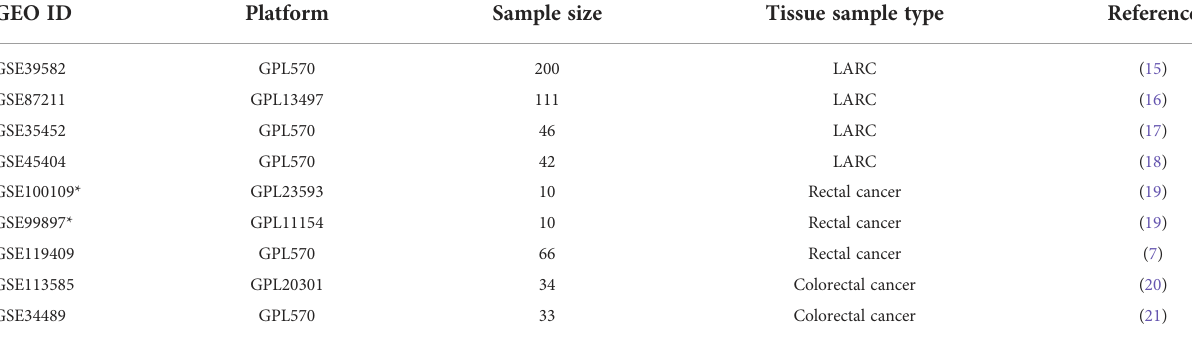
TABLE 1 Datasets analyzed in this study. GEO